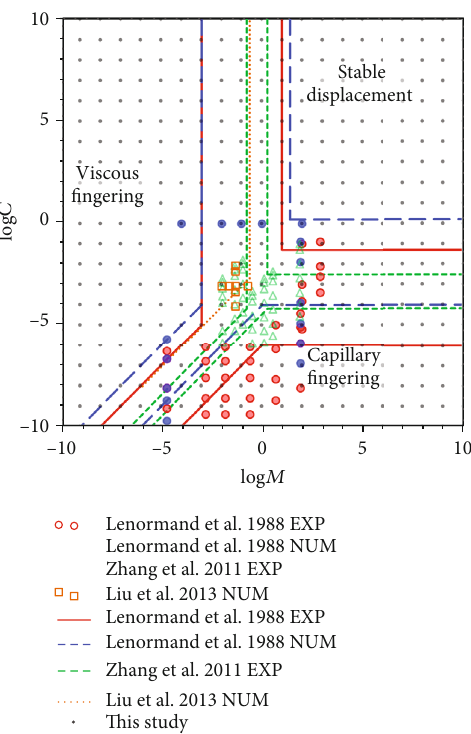
Figure 1: Boundaries of three displacement patterns with respect to log M and log C : stable displacement (upper right), viscous fi ngering (left), and capillary fi ngering (lower right). The symbols (circle, triangle, and square) represent the values of log C and log M used for the micro fl uidic chip experiment and the pore- network model or a lattice Boltzmann simulation in the literature. The lines indicate the phase boundaries identi fi ed in previous studies. The values of log C and log M used in previous studies have a very limited range, particularly in the transition zone. A wide range of log C and log M values (represented by grey dots) was used in the present